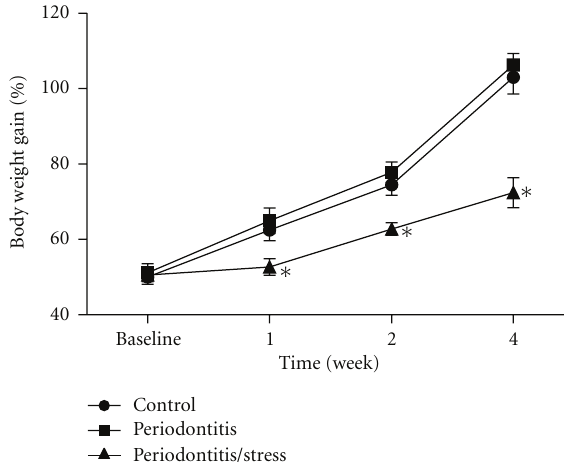
Figure 2: Body weight gain of the rats in all groups. (cid:0) P versus control group at the same time